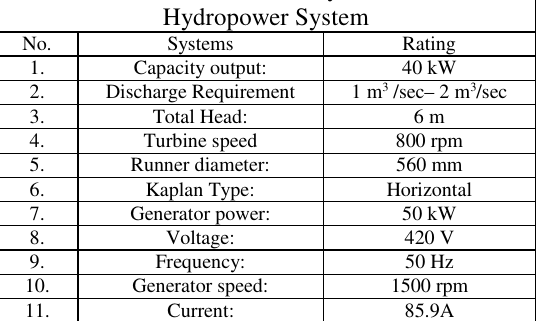
Table 2: Parameters of newly modeled small Hydropower